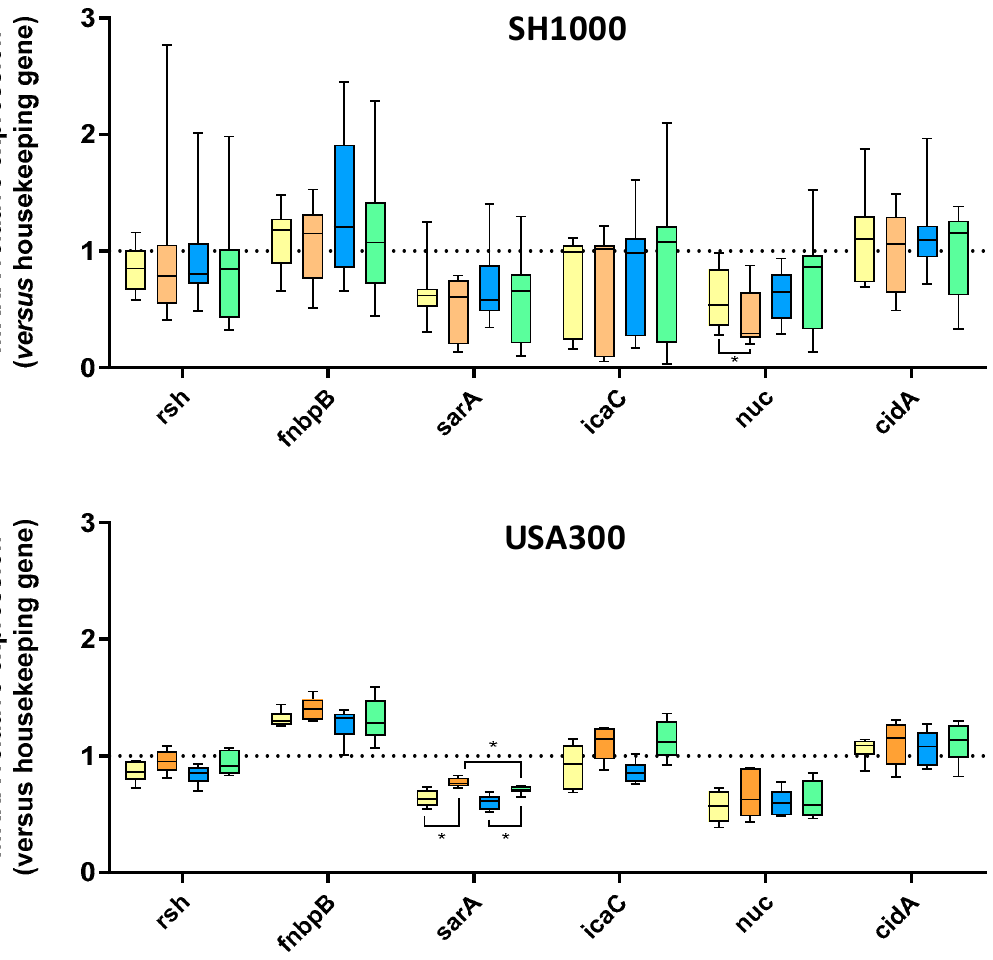
Figure 5. Influence of Saos-2 culture supernatant on biofilm-embedded S. aureus gene regulation. Results represent relative mRNA expressions of bacteria within biofilms for SH1000 and USA300.